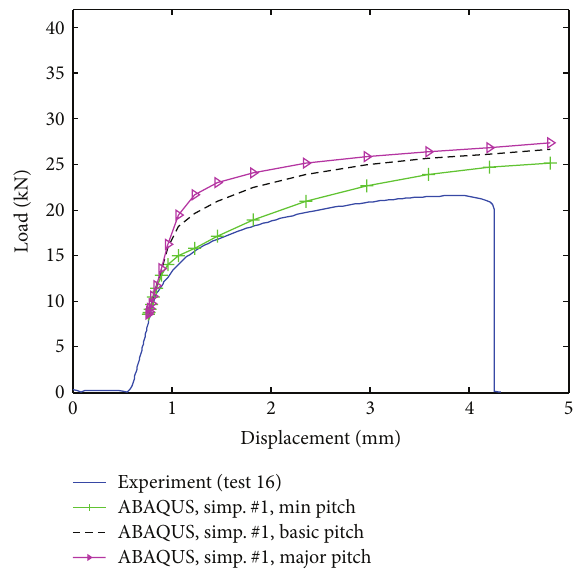
Figure 12: Force-displacement results for static tension test, simpli- fied model #1, using diameter values equal to minimum, basic, and maximum thread pitch in the threaded